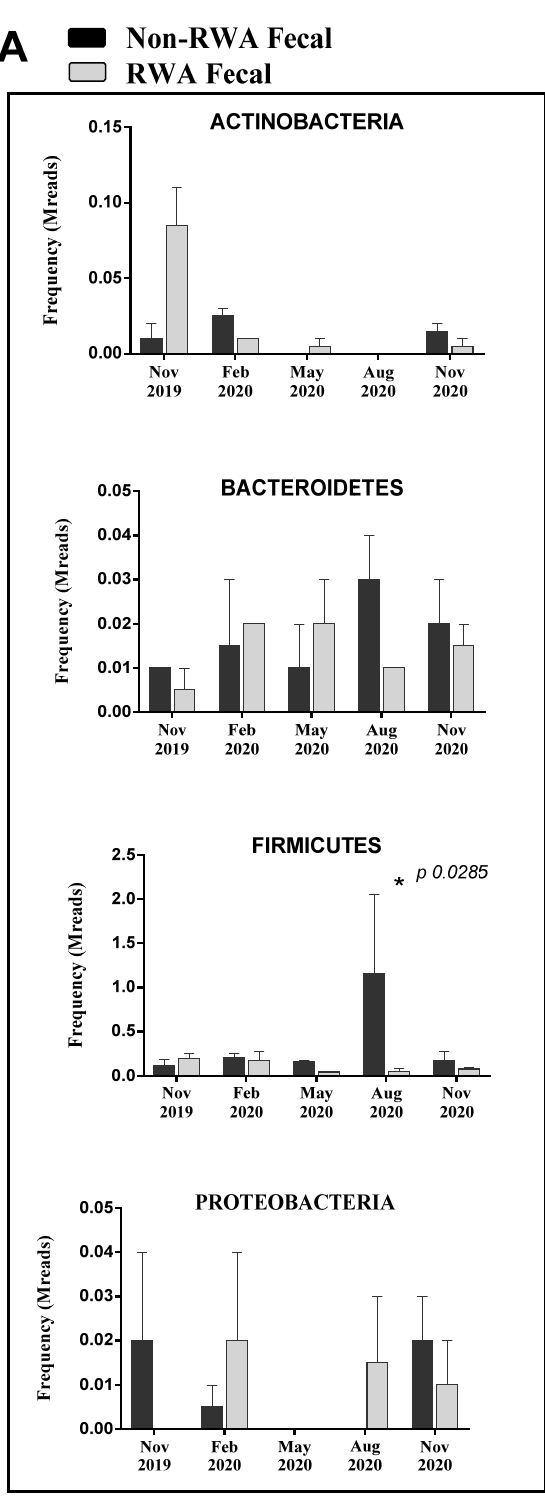
Figure 2. Pathogen prevalence in sow feces ( A ) and sow nasopharynx ( B ) samples. The bars represent the averaged frequency of the pathogens obtained from all bacteriome phyla by extracting the subset of human and/or animal Risk Group 2 species. Two data sets from each type of farm (non-RWA and RWA) were included as biological replicates for statistical analysis. ANOVA 2-way analysis with repeated measures comparing RWA vs. non-RWA with Bonferroni’s correction; * p < 0.05, ** p < 0.01.